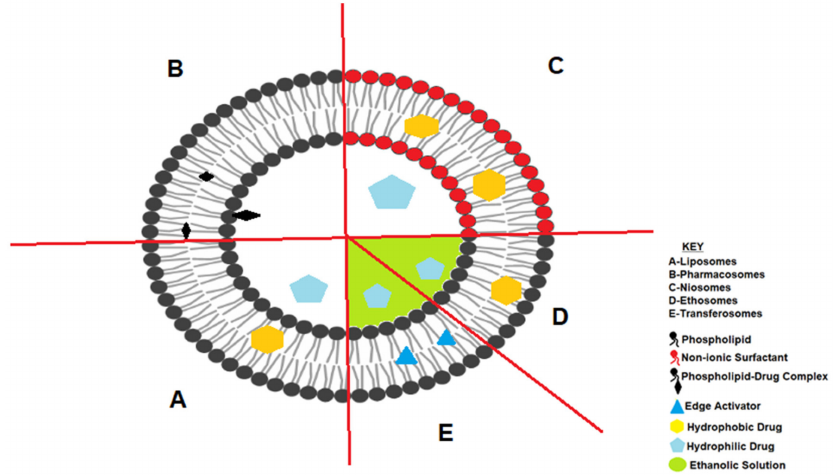
Figure 4. Schematic representation of the various bilayered lipid–lipid based nanocarriers. Liposomes ( A ); Pharmacosomes ( B ); Niosomes ( C ); Ethosomes ( D ); and Transferosomes ( E